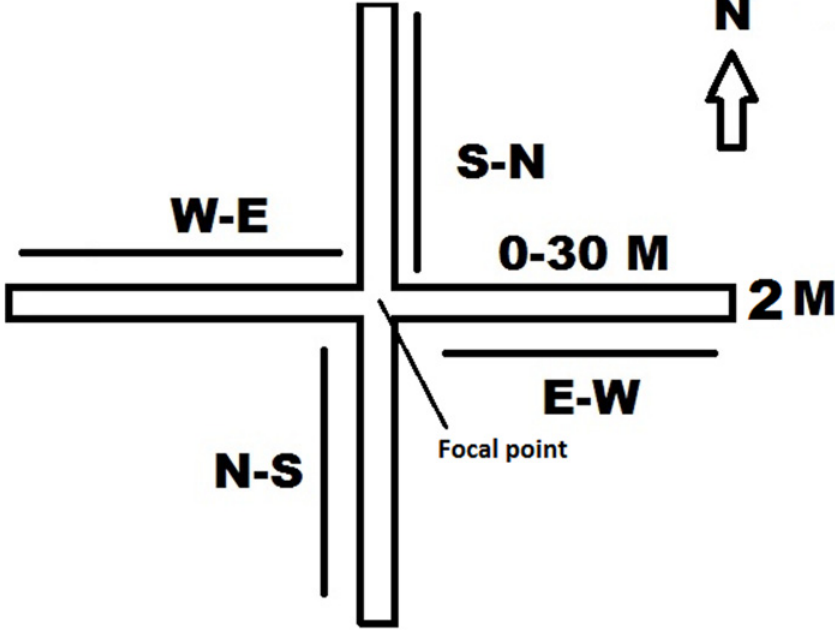
Fig 2. A model of the four-direction plots (FDP) established in a large population of A . roxburghii to compare robbed and unrobbed